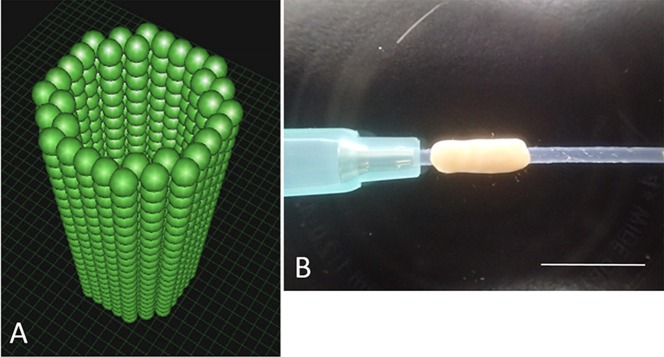
A: The pre-designed 3D tube-like structure. The green spheres represent homogeneous multicellular spheroids that were developed using only human normal dermal fibroblasts. B: The Bio 3D conduit according to the pre-designed 3D model. The conduit was cannulated via a 18-gauge intravenous catheter (SURFLO: NIPRO, Osaka, Japan). Scale bar = 10 mm.